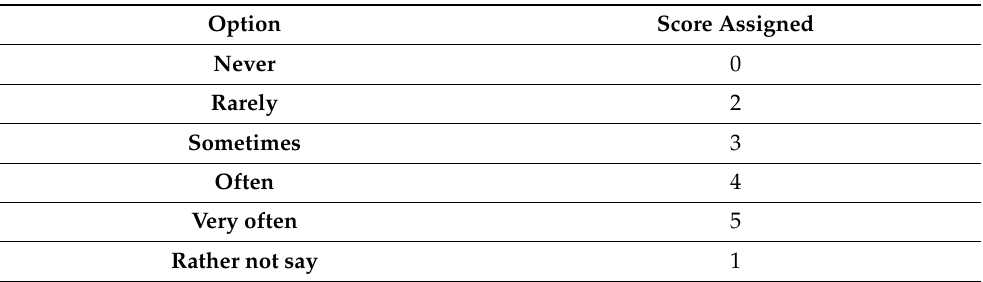
Table 5. Scores assigned to the different answer options in the group of questions regarding life- satisfaction and worth.